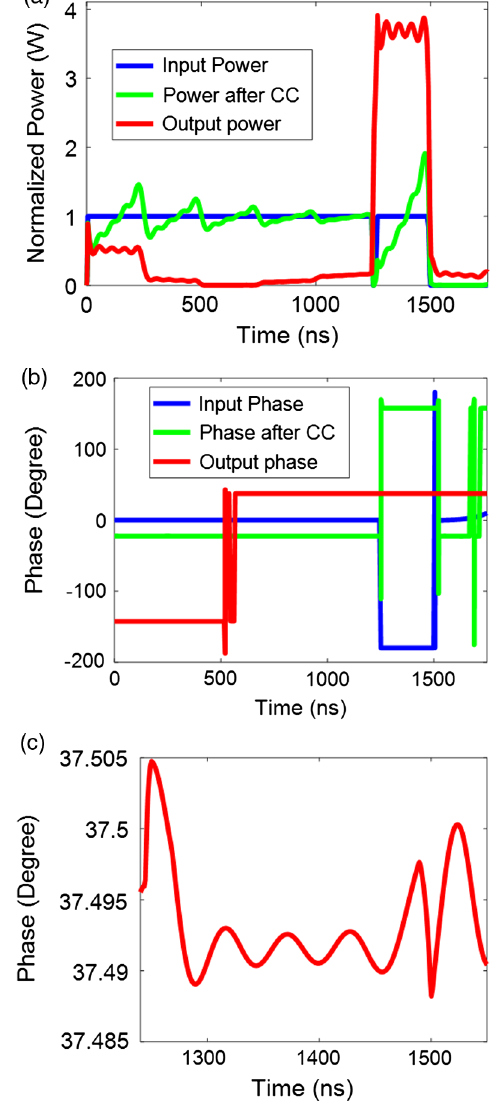
FIG. 4. (a) Input waveform, waveform after passing through the correction cavity chain, and the output waveform. (b) Input phase, phase after passing the correction cavity chain, and the output phase. (c) Output phase within the period with high peak power.